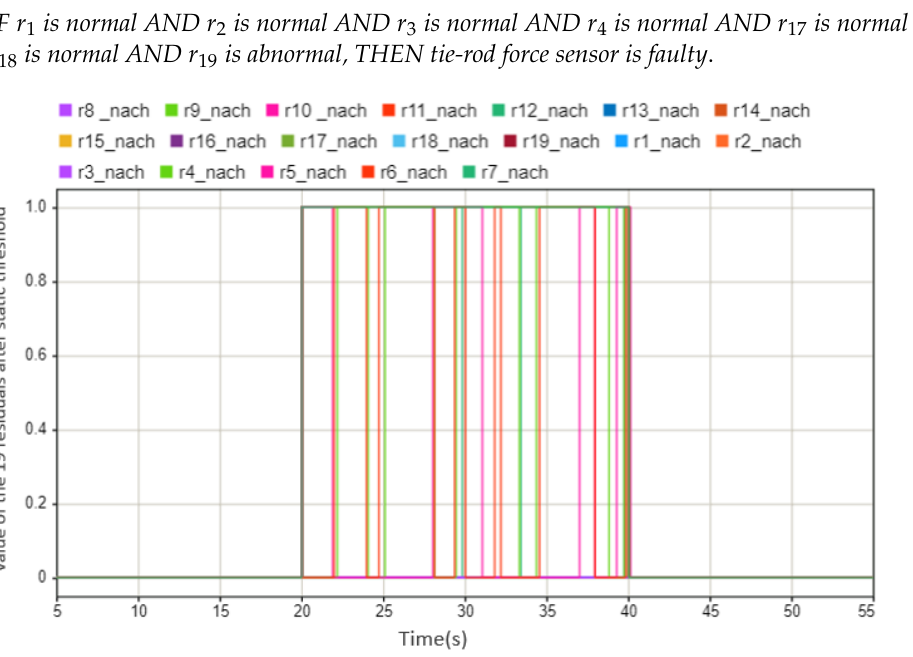
Figure 7. The values of the 19 residuals after threshold. This case shows that the state of sensors is abnormal between the 20 s and 40 s (0 means there is no abnormal situation, 1 means there is an abnormal